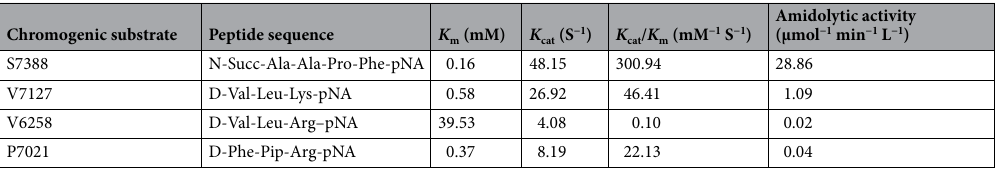
Table 2. Amidolytic activity of the UcB5 on the chromogenic substrates. Five microliters of the enzyme in 20 mM Tris–HCl buffer at pH 8.0 was incubated per 100 µL of a synthetic substrate at 0.02–0.15 mM concentrations at 37 °C. The colored para nitroaniline liberated from the reaction was measured at A 405 nm. Depending on the velocity of the reaction, the kinetic parameters were deduced from the Lineweaver–Burk